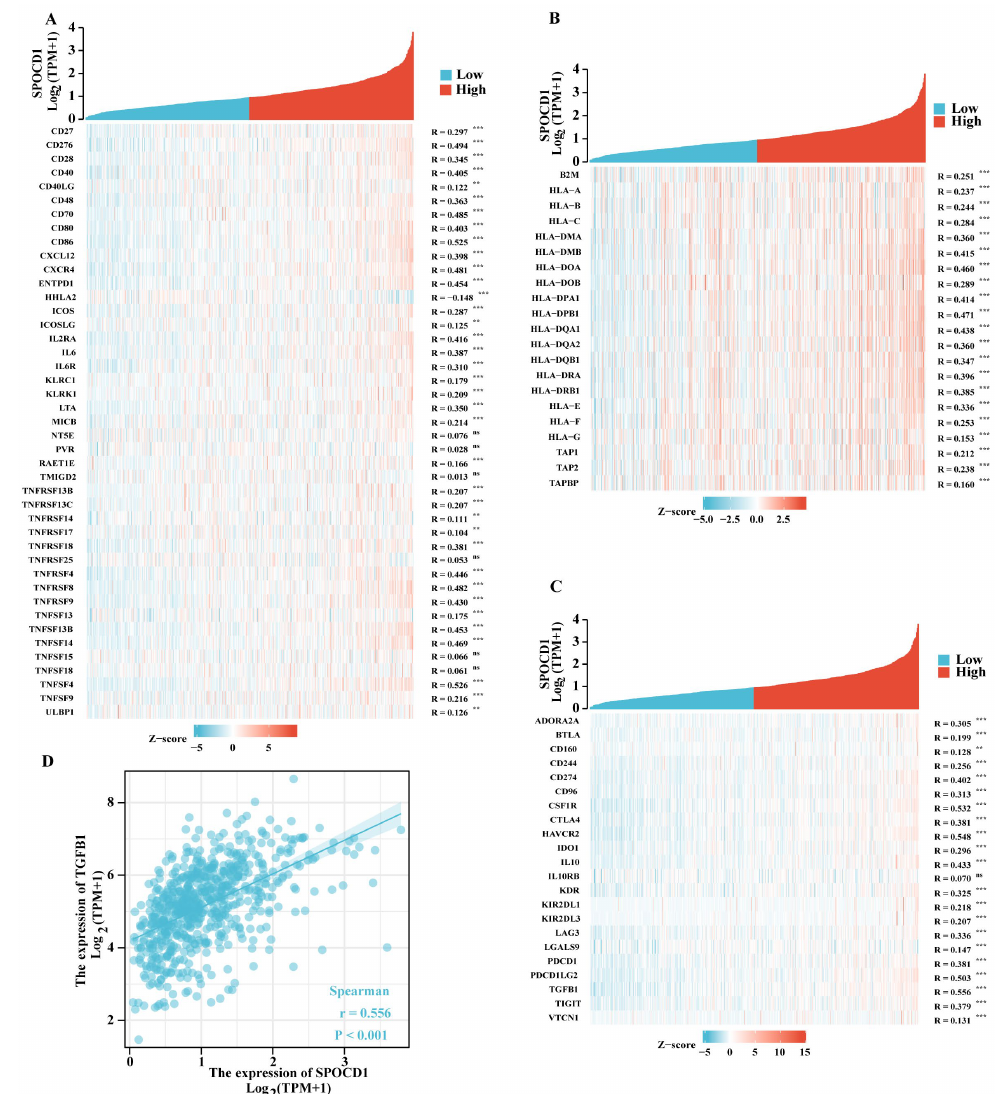
Figure 6. Correlation between SPOCD1 expression level and immunological microenvironment biomarkers in CRC. ( A ) Correlation between SPOCD1 and immunostimulatory gene expression in CRC. ( B ) Correlation between SPOCD1 and MHC molecule expression in CRC. ( C ) Correlation between SPOCD1 and immunoinhibitory gene expression in CRC. ( D ) Correlation between SPOCD1 expression and TGFB1 in CRC (ns represents no significance, ** p < 0.01, *** p < 0.001).